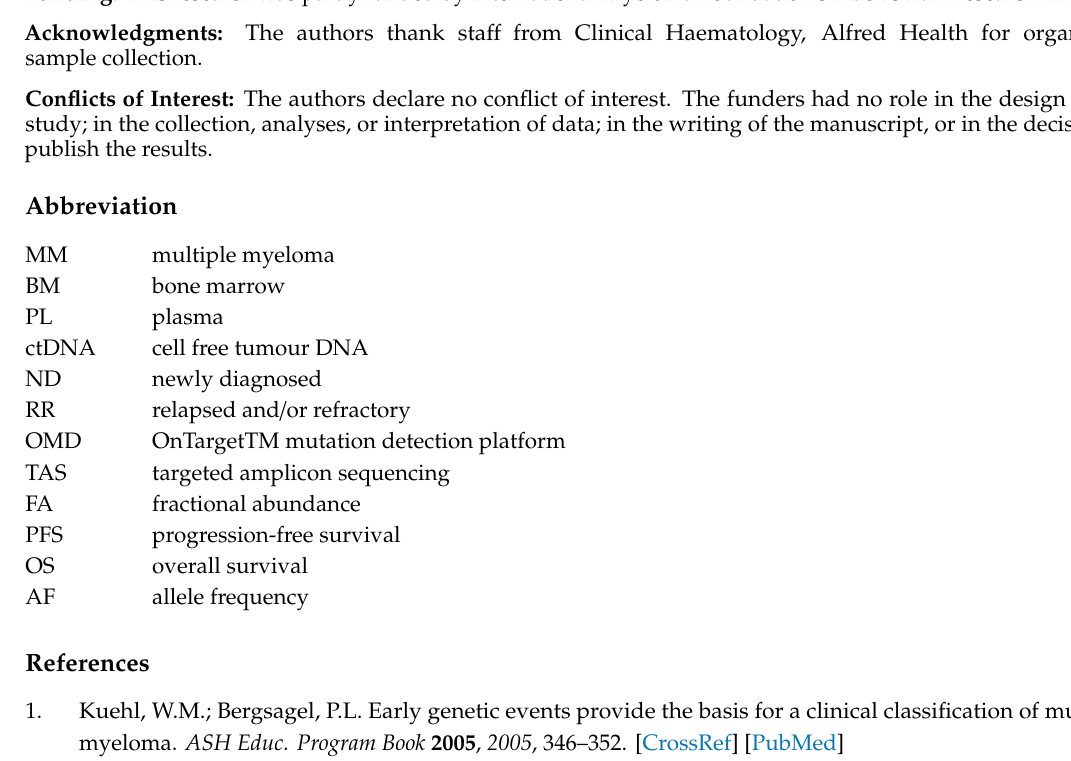
Table S1: List of mutations detected by OMD and TAS in MM